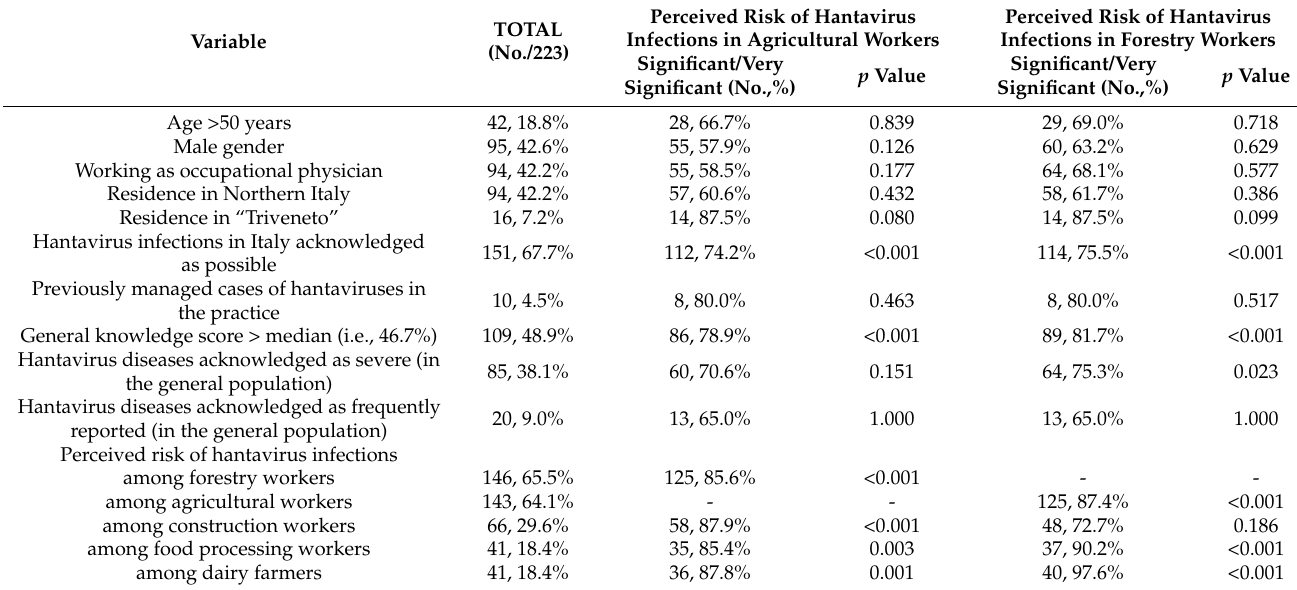
75.5%, respectively; p < 0.001 in both cases). Similarly, acknowledging higher risk for frequently reported a greater concern for hantavirus infections among food processing workers (85.4% and 90.2%, p = 0.003 and p < 0.001, respectively) and dairy farmers (87.8% and 97.6%, p = 0.001 and p < 0.001, respectively). Eventually, acknowledging hantavirus infections as severe ones was more frequently reported by professionals perceiving a higher occupational risk for forestry workers alone (75.5%, p = 0.023). Table 4. Univariate analysis of factors that in participating health care providers (No. = 223) were associated with higher risk perception for hantavirus infection in agricultural and forestry workers. Comparisons were performed by means of chi squared test (with Yates